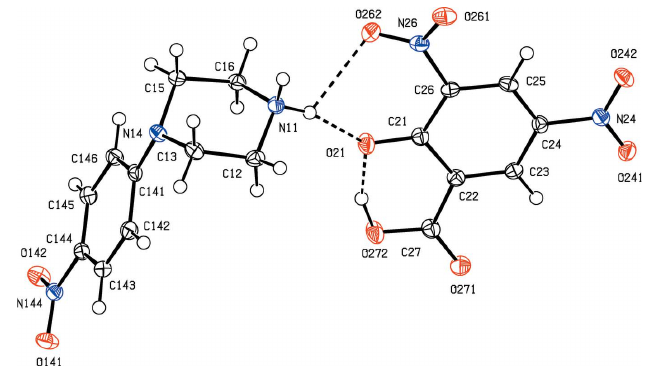
Figure 1 The molecular structure of (I), showing hydrogen bonds (drawn as dashed lines) within the selected asymmetric unit. Displacement ellipsoids are drawn at the 50% probability level.